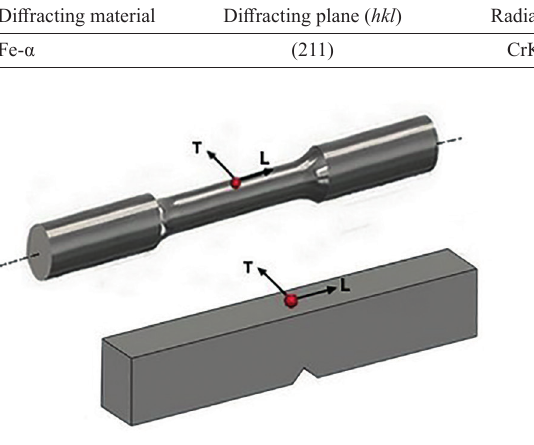
Figure 3: Residual stresses analysis directions.